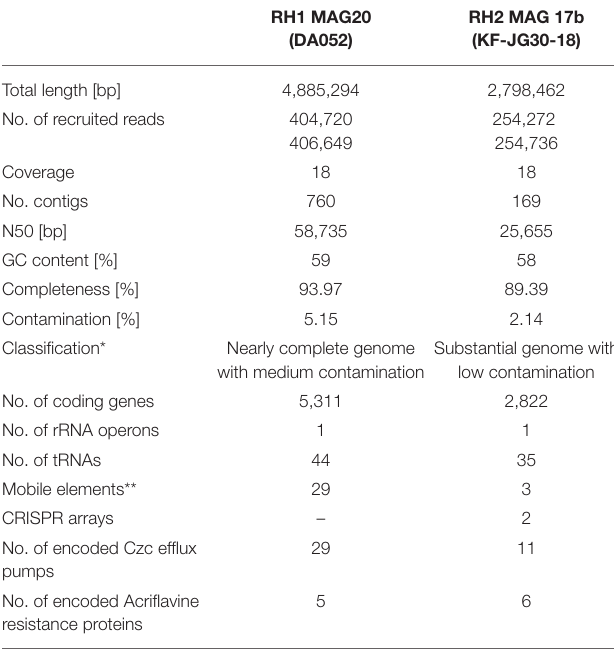
TABLE 1 | Characteristics of RH1 MAG 20 (DA052) and RH2 MAG 17b